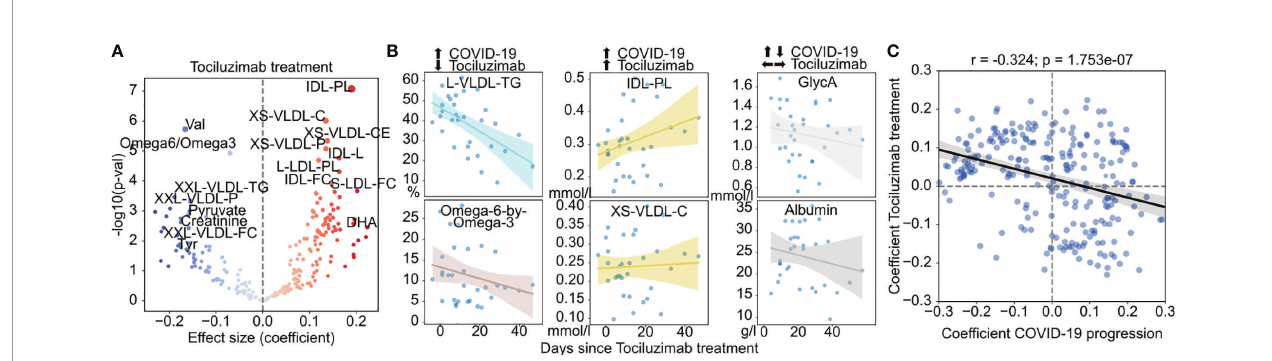
FIGURE 2 | Effect of tocilizumab treatment on the metabolism of COVID-19 patients. (A) Association of metabolite abundance with the time since tocilizumab treatment. The coef fi cient values refer to the change per day in relation to the mean. (B) Abundance of metabolites with discordant (left), concordant (center) or indifferent (right) change between COVID-19 severity and tocilizumab treatment for treated patients. (C) Comparison of the coef fi cients of change in COVID-19 severity (x-axis) and effect of tocilizumab treatment over time (y-axis). The black regression line indicates a overall linear trend across